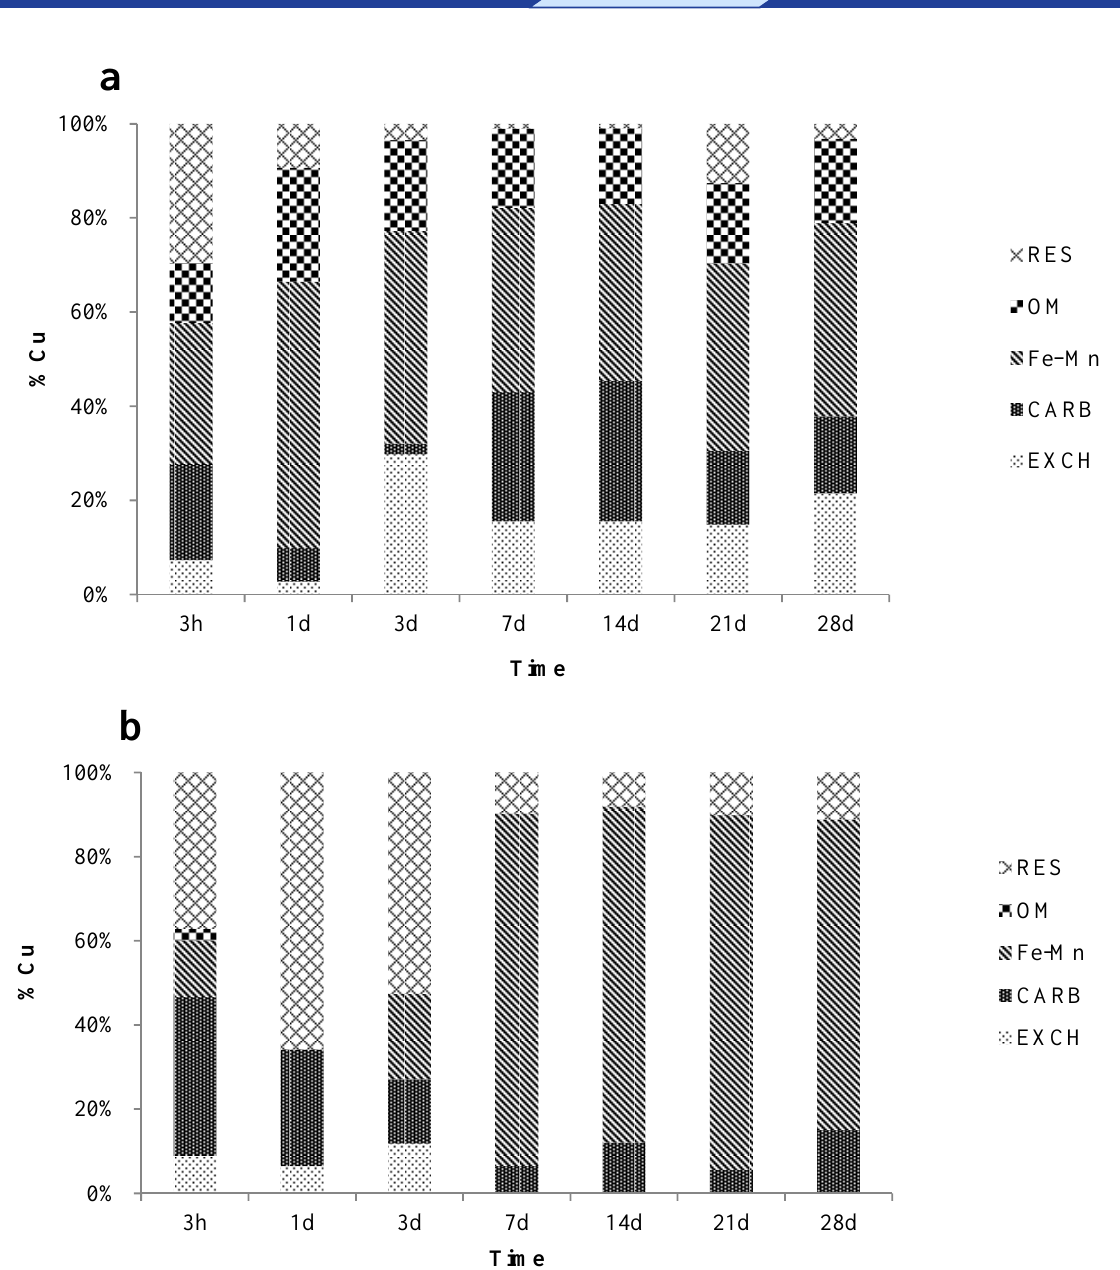
Figure 1. The change of Cu (%) in different fractions with time in contaminated soil with (a) Actinidia deliciosa shell (b) in the control soil RES: Residual; OM: Organic matter; Fe–Mn: Fe-Mn oxides; CARB: Carbonate-bound; EXCH: